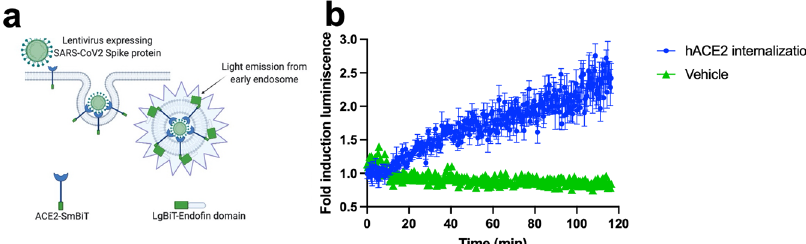
Fig. 7 Monitoring SARS-CoV2 infection in real-time in living HEK293 cells. a Schematic representation of how the Lentivirus expressing the SARS-CoV2 Spike protein is internalized by binding with Angiotensin-Converting Enzyme 2 (ACE2) via early endosomes. b Real-time monitoring of viral entry into HEK293 cells expressing human ACE2 when treated with the Lentivirus. The arrow indicates the time when the cells were treated with the virus. The results are expressed as mean ± s.e.m. of three experiments performed in triplicate; each triplicate was averaged before calculating the s.e.m. The corresponding Z ’ score was